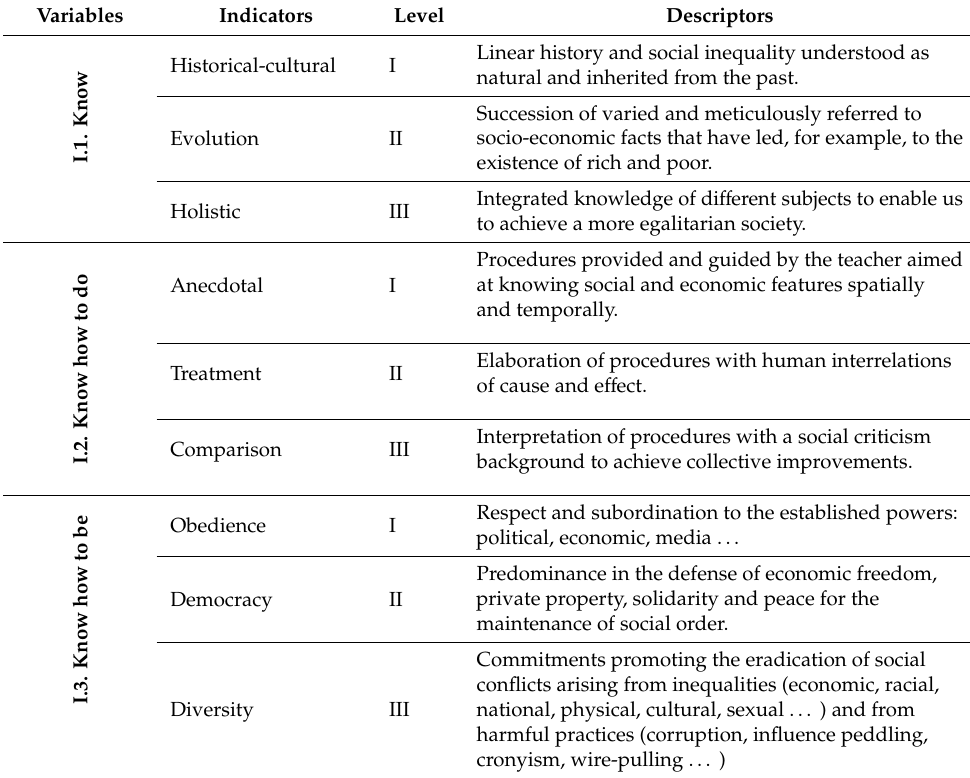
Table 4. System of categories by levels of complexity ( Category: I. Objectives